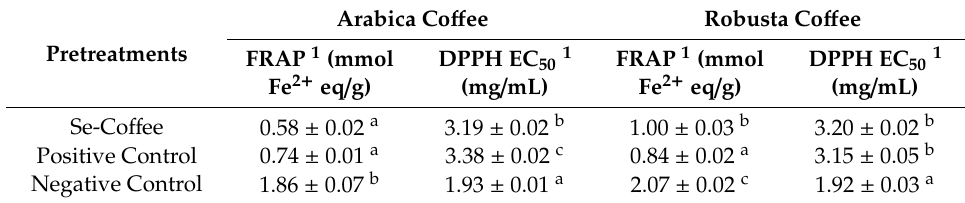
Table 1. Ferric reducing antioxidant power (FRAP) reducing activity and 2,2-diphenyl-1-picrylhydrazyl (DPPH) scavenging activity expressed as EC 50 for green Se-co ff ee (pretreated with selenium), positive control (pretreated without selenium), and negative control